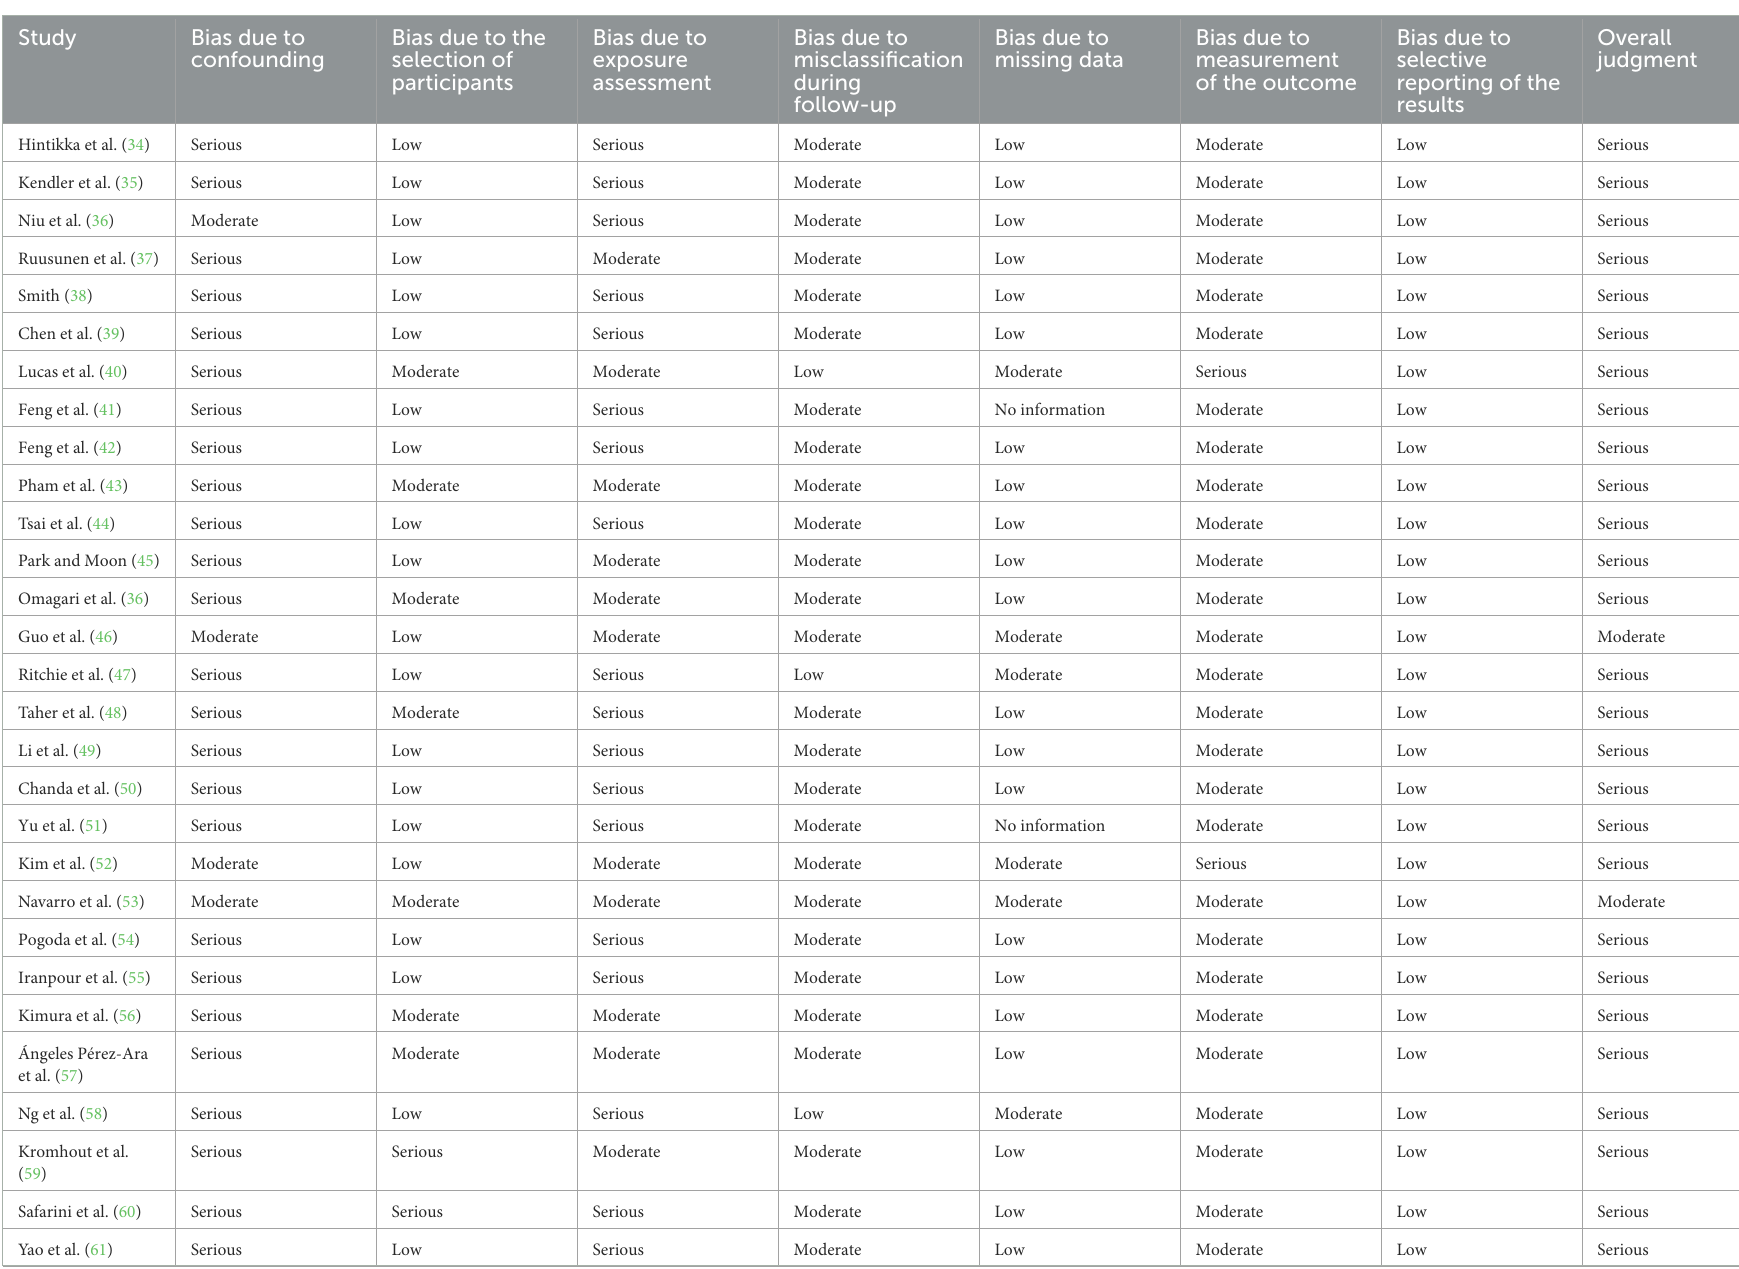
TABLE 2 ROBINS-I judgment for each domain and